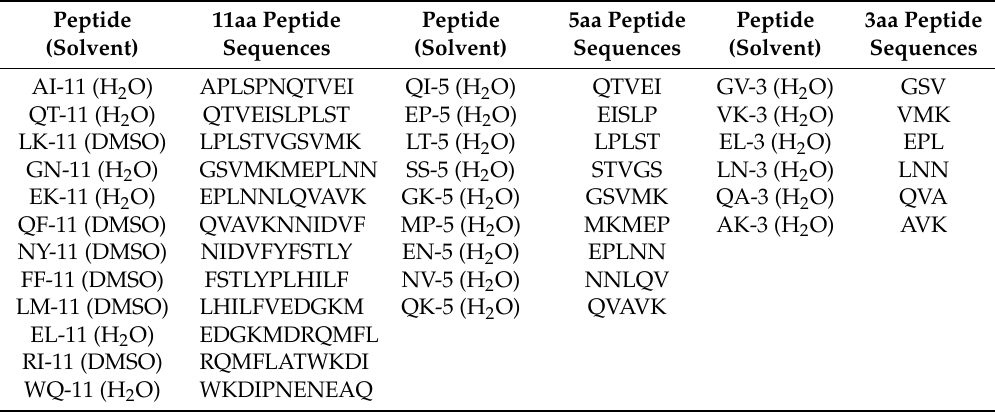
Table 1. Peptides derived from the human β 1-adaptin sequence (position 783–860) and their respective solvent used in this